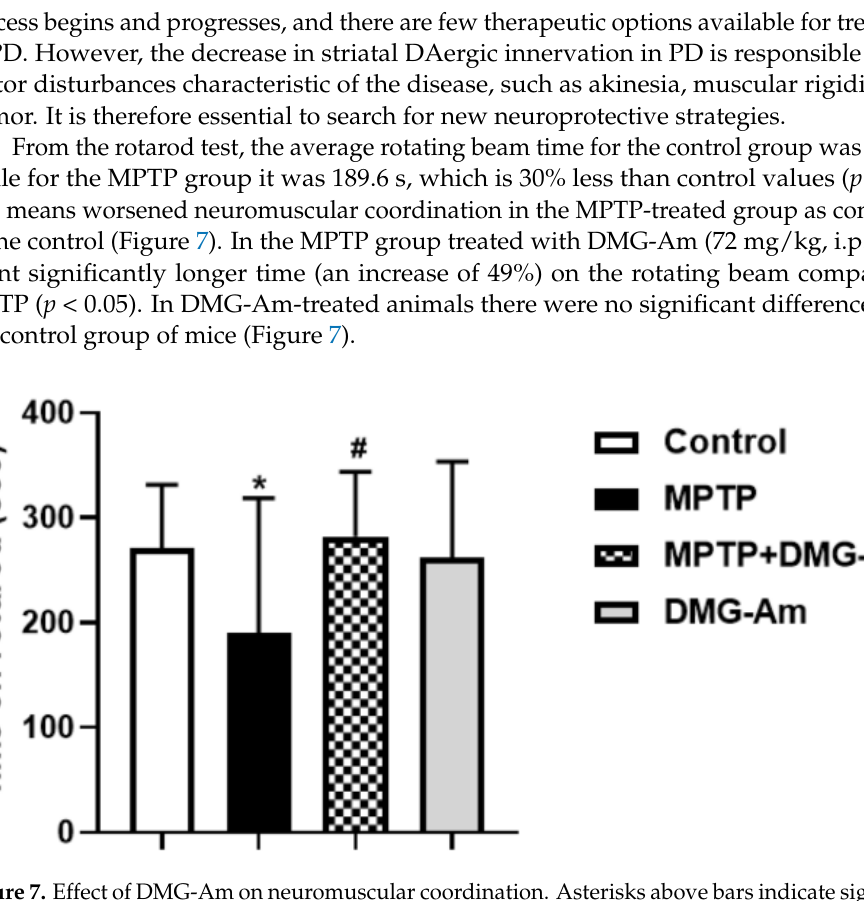
Figure 8. Effect of DMG-Am on step-through latency (STL) in the single-trial passive avoidance test in a mice model of PD: ( a ) STL time 1 h; and ( b ) STL time 24 h. Significance vs. control group: * p < 0.05; significance vs. MPTP-treated group # p < 0.05; ## p < 0.01. Statistical analysis was performed by one-way analysis of variance (ANOVA), followed by Dunnett’s post hoc comparison test. Our results showed that the systemic administration of MPTP worsened the motor and memory performance of the animals in the behaviour test used. This manifests itself as less time spent on the gyratory in the rotarod test and reduction of STL 1 h and 24 h after the acquisition phase in the passive avoidance test, an indication for memory lost effect.